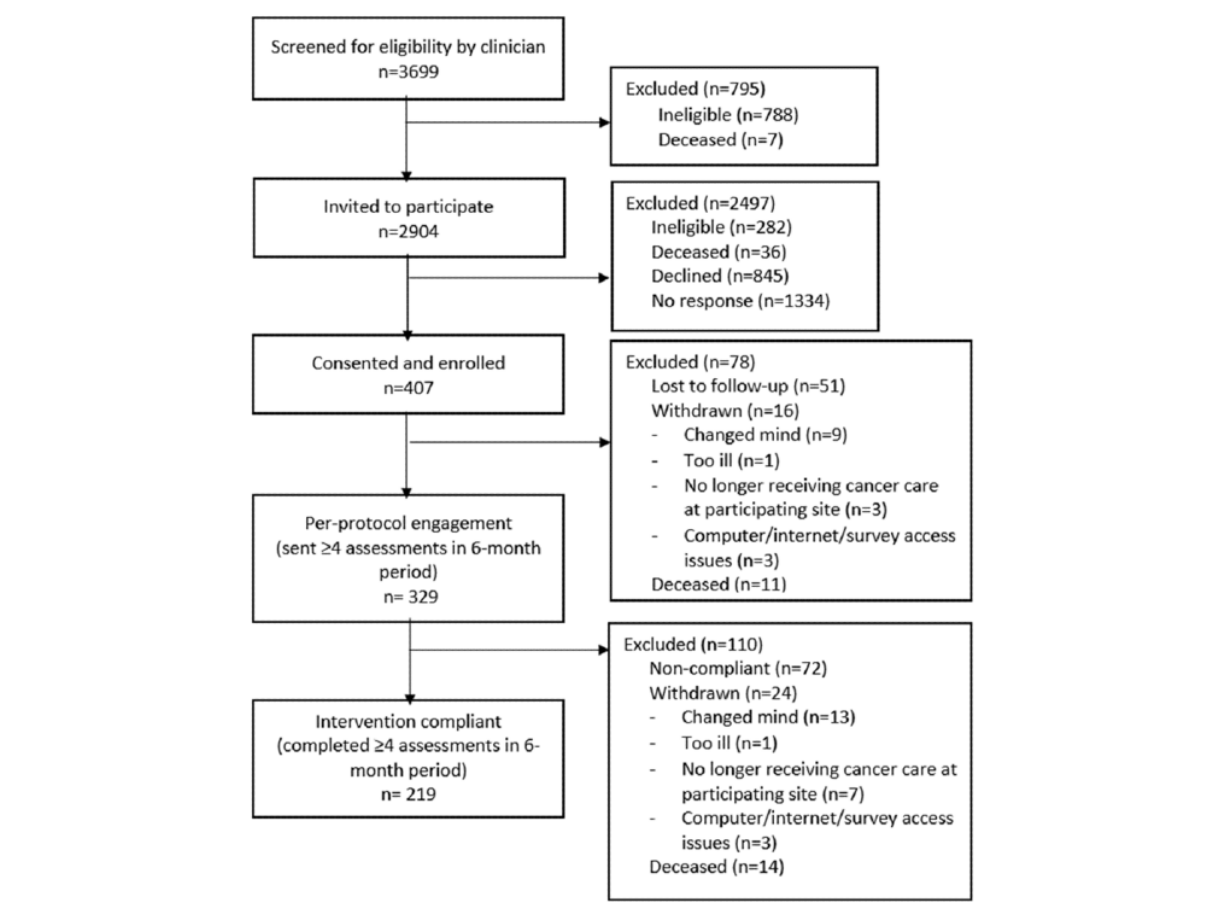
Figure 3. CONSORT